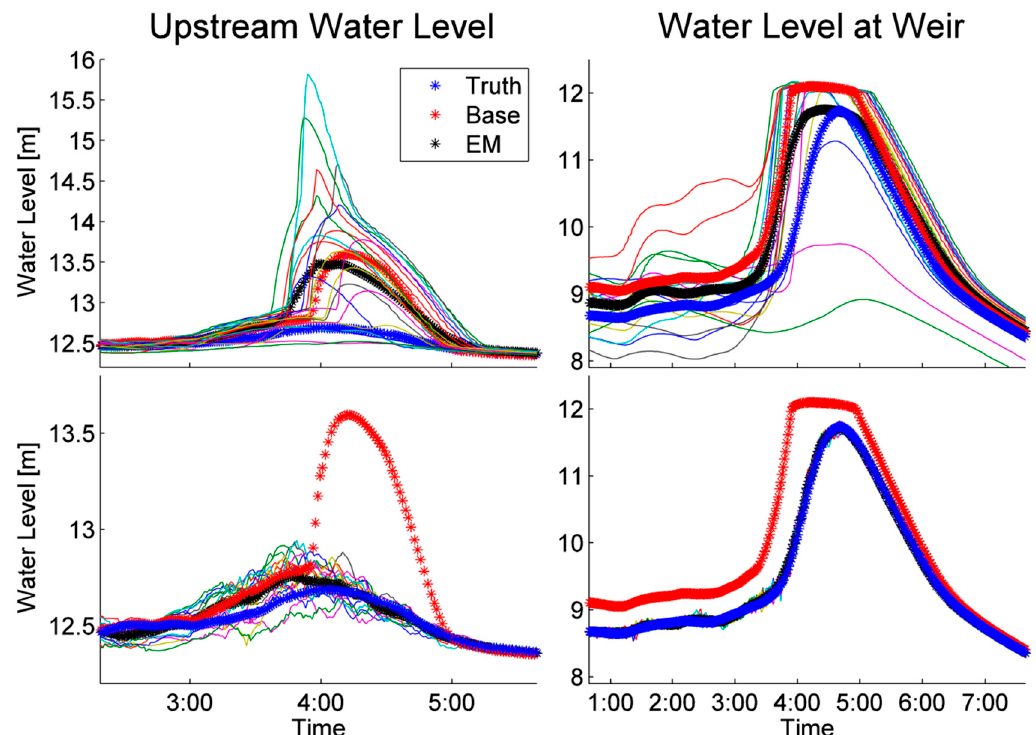
Figure 2. Ensemble of 20 models (thin curves) without updating (upper panels) and with Ensemble Kalman Filter (EnKF) updating (lower panels). The left panels show the water level at the upstream validation point while the right panels show the water level at the downstream weir. The dotted blue line shows the true water levels, the dotted red line the simulated water levels using the measured rainfall without updating the model and the black line the ensemble mean.